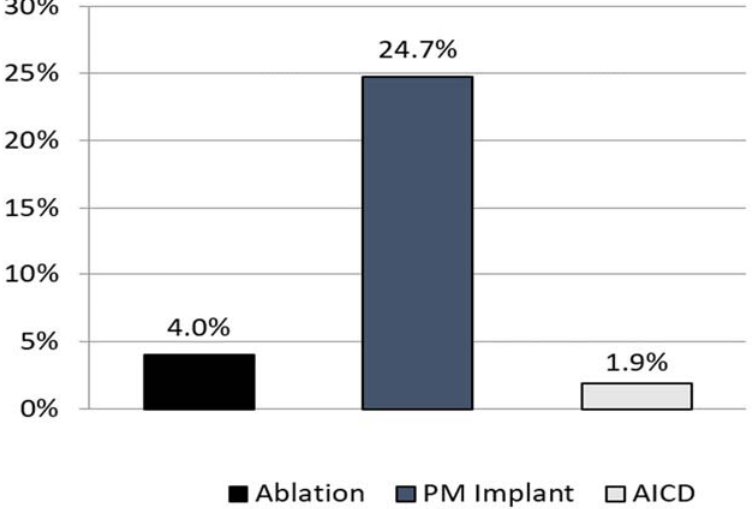
Figure 3. Therapeutic interventions over the 2-year follow-up period. Abbreviations: PM: pacemaker; AICD: automatic implantable cardioverter-defibrillator.